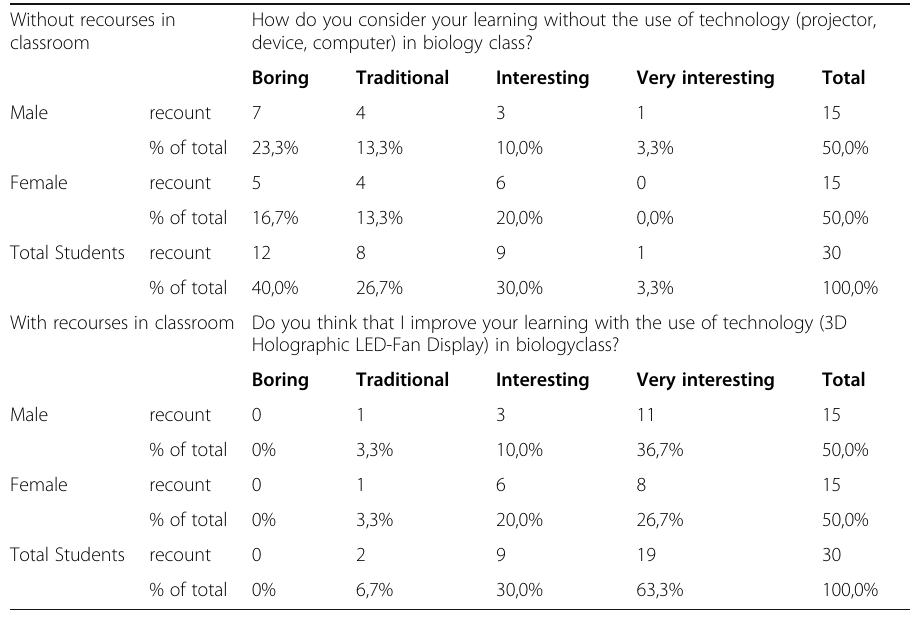
Table 3 Comparative pre and post- questionnaire about learning with technological resources. Cross